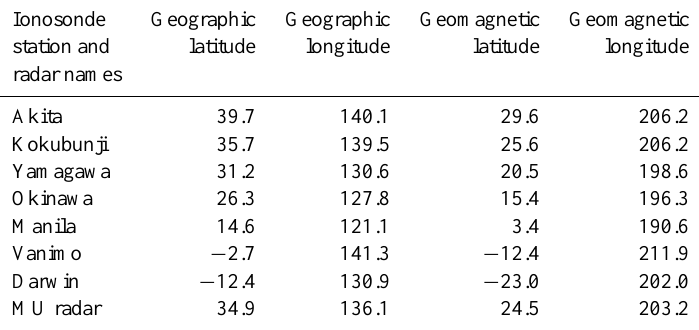
Table 1. Ionosonde station and radar names and locations. Ionosonde Geographic Geographic Geomagnetic Geomagnetic station and latitude longitude latitude longitude radar names Akita